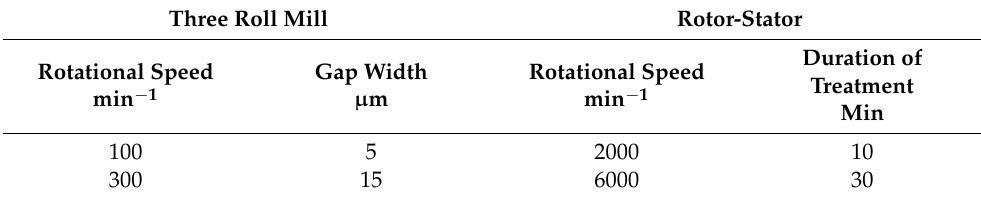
Table 2. Factors used in dispersion preparation for percolation